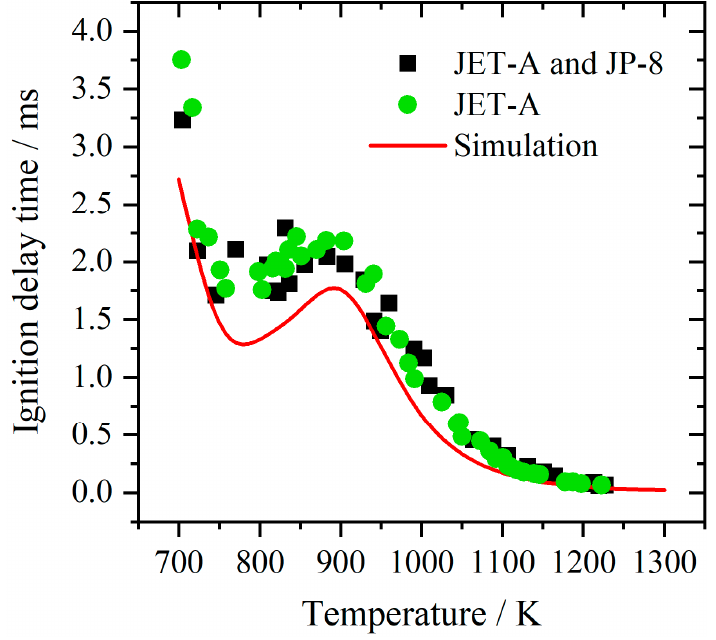
Figure 1. Validation of the chemical reaction mechanism of kerosene.